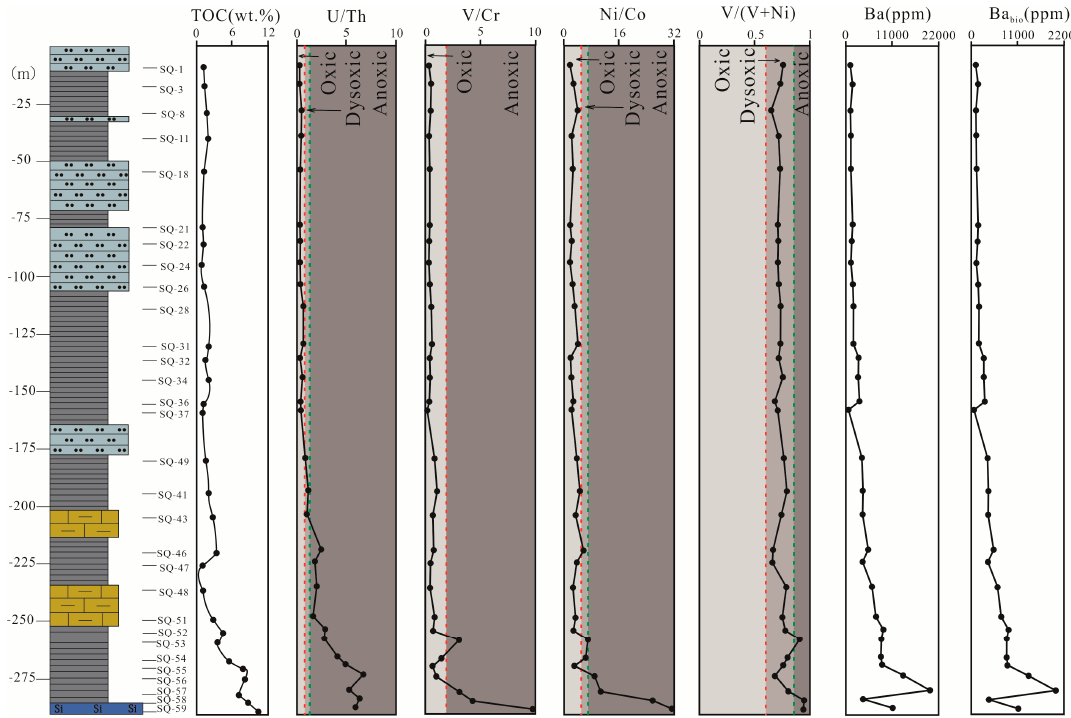
Figure 13. Stratigraphic profiles of SQ-1 for total organic carbon (TOC), U/Th, V/Cr, Ni/Co, V/(V + Ni), Ba, and Ba bio . The thresholds of V/(V + Ni) (0.6,0.85) are referred from [37]; Redox thresholds of U/Th (0.75,1.25), V/Cr (2.0), and Ni/Co (5.0,7.0) are referred from [38].